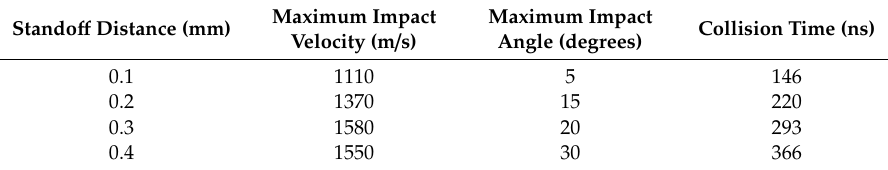
Table 6. The e ff ect of stando ff distance based on axisymmetric LIW